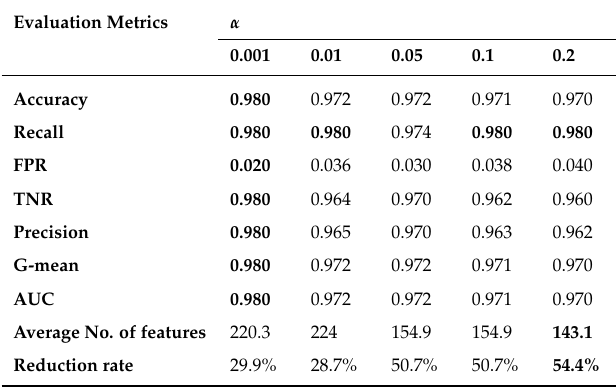
Table 6. The effect of alpha parameter on the fitness of the SSA